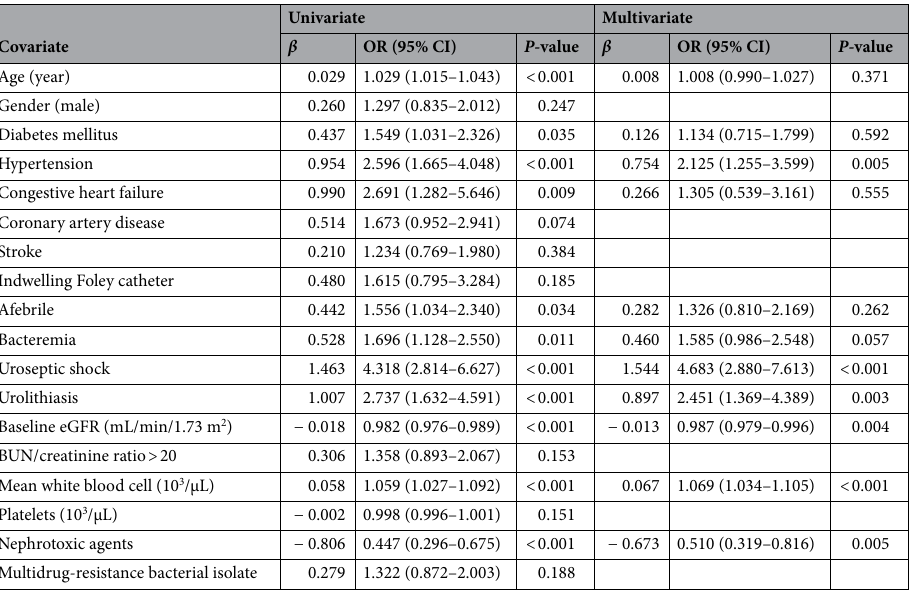
Table 5. Univariate and multivariate logistic regression analyses of factors related to acute kidney injury in hospitalized urinary tract infection patients without hydronephrosis. Cox & Snell R 2 = 0.119, Nagelkerke R 2 = 0.240. eGFR estimated glomerular filtration rate, BUN blood urea